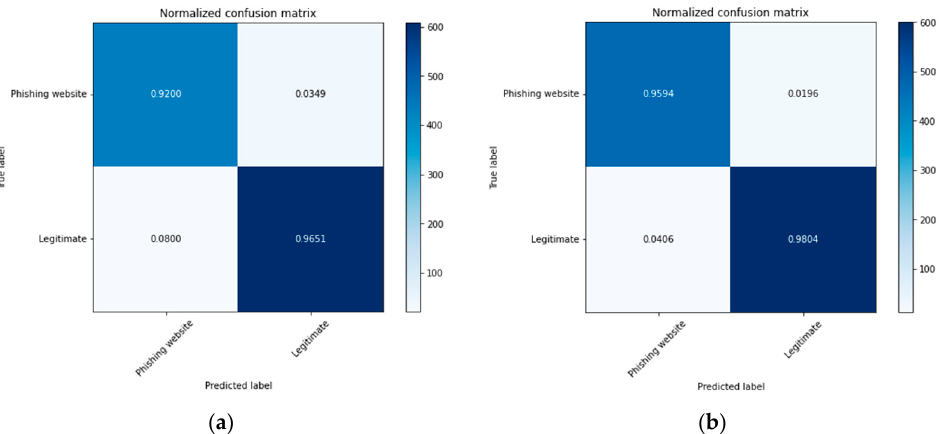
Figure 7. A normalized confusion matrix of GradientBoost for phishing website and legitimate website classification: ( a ) with default parameters; ( b ) with optimized parameters for Dataset 1.